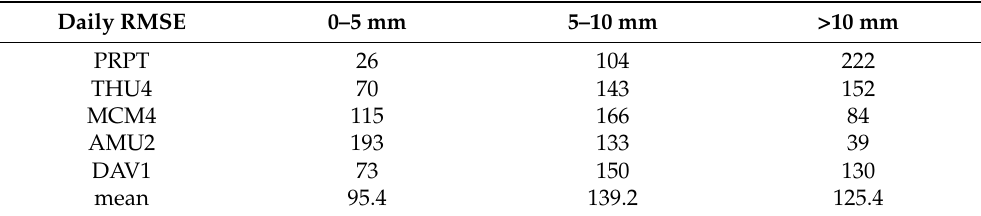
Table 1. Daily RMSE piece-wise statistic result of LSTM_ZTD from 24 October 2020 to 23 October 2021 at PRPT, THU4, MCM4, AMU2 and DAV1 station (units: